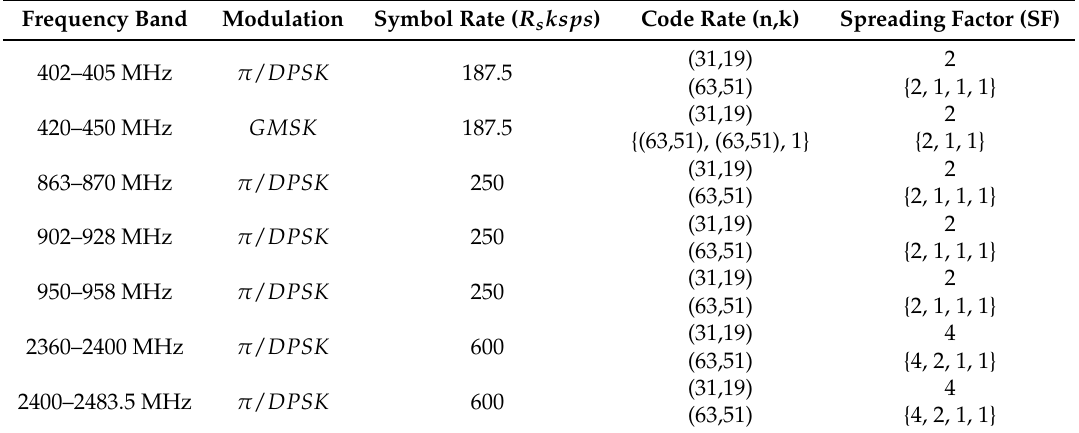
Table 2. Narrowband (NB) physical layer (PHY) specification.